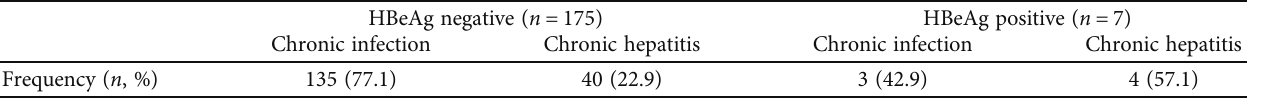
Table 2: Categorization of asymptomatic patients by HBeAg and hepatitis status.